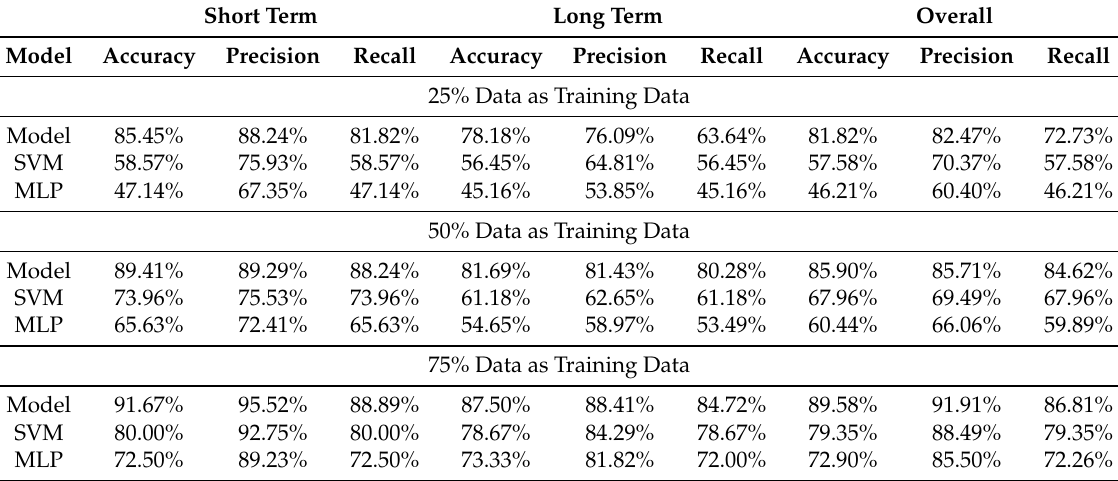
Table 11. Prediction: model accuracy, precision, recall.